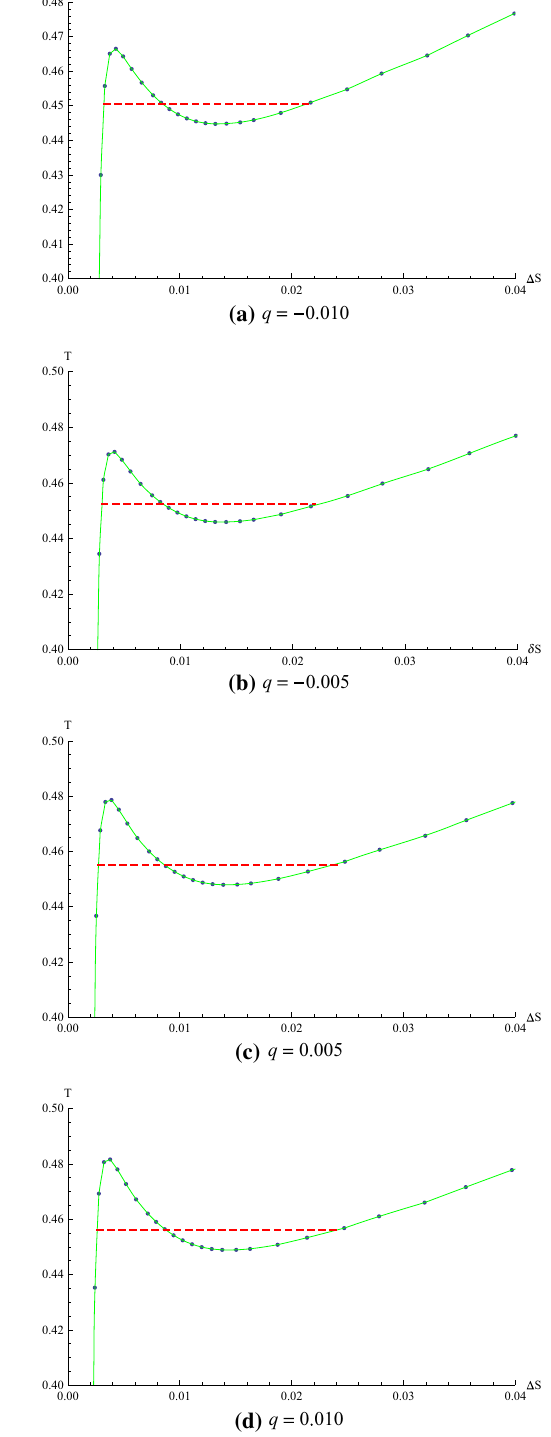
Fig. 6 Plots of isocharges in the T – (cid:8) S plane for ϕ 0 = 0 . 50. The red dash line corresponds to the temperature of the first order phase transition for Q < Q C . a Q = 0 . 0286384 < Q C . b Q = 0 . 0338006